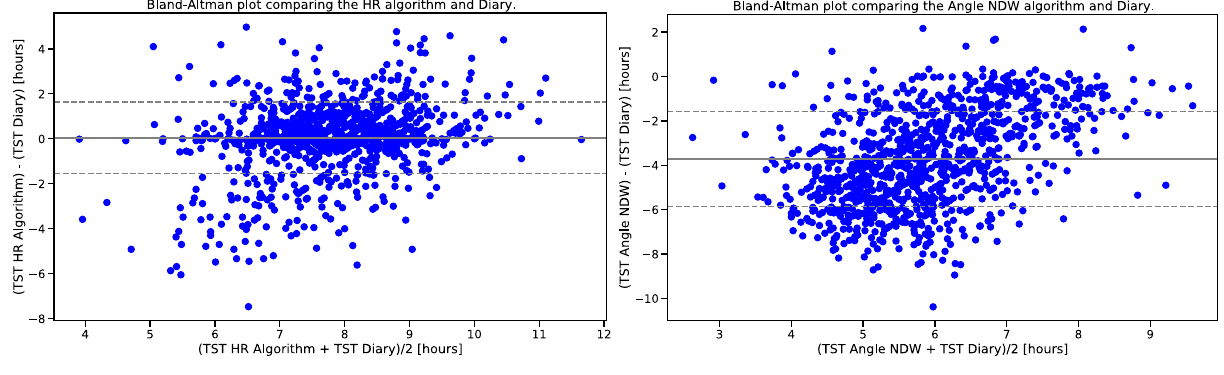
Figure 4. Modified Bland-Altman plot for BBVS. Modified Bland-Altman plot on the left shows the TST differences (delta) between the full-day HR algorithm and diary in the Y-axis and the X-axis shows the TST average for every participant. The figure to the right shows the same comparison for the angle algorithm and diaries in BBVS. Dashed lines represent limits of agreement (LoA) which are defined as the mean difference ± 1.96 SD of differences. TST: total sleep time.